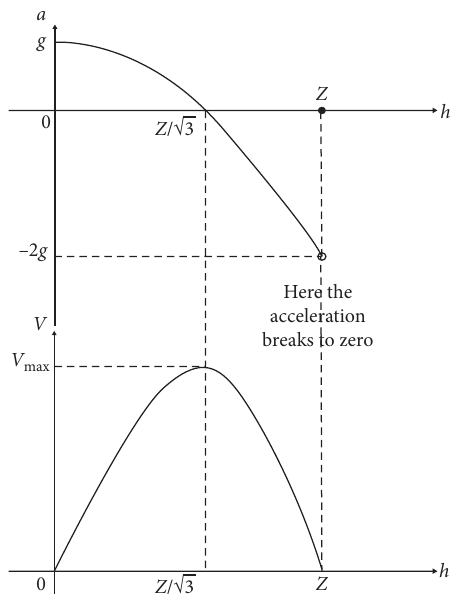
Figure 1: Diagram of acceleration a and velocity v varying with depth h of fall cone.